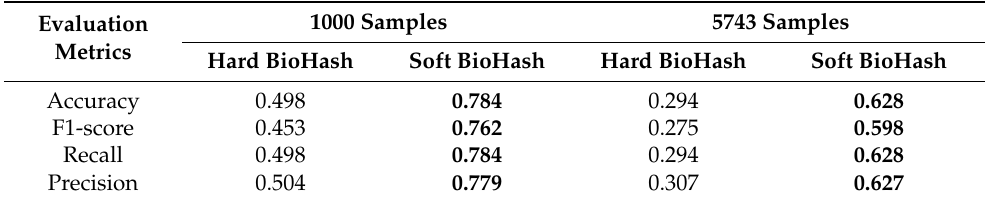
Table 2. Performance comparison of various evaluation metrics.